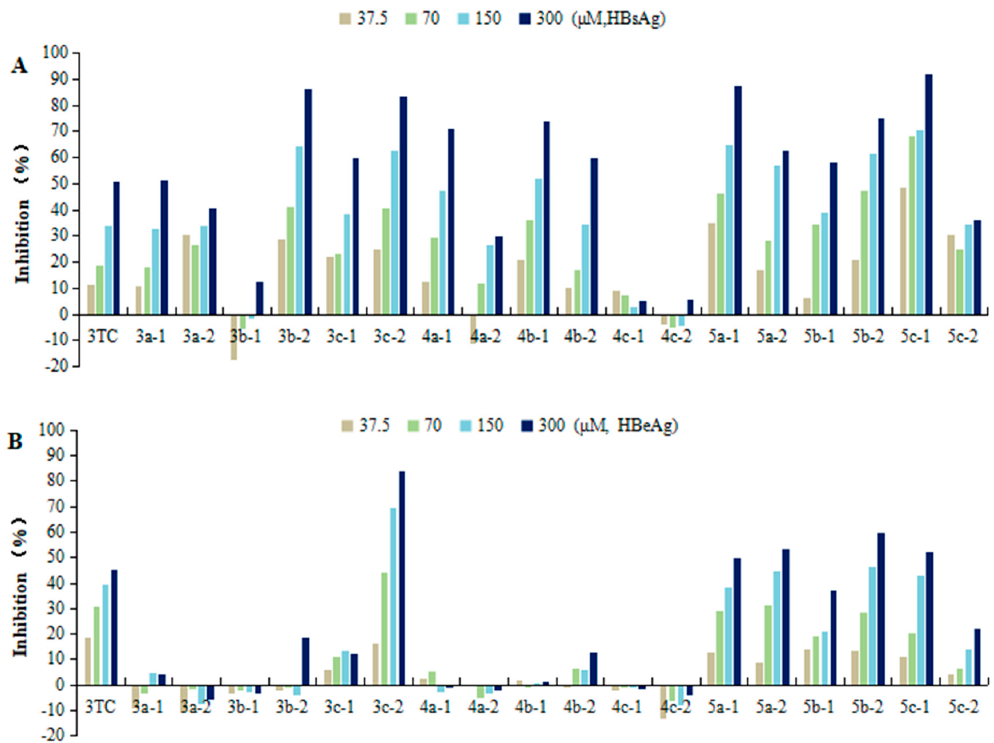
Figure 4. Inhibitory effects of the compounds on secretion of HBsAg ( A ) and HBeAg ( B ) in the HepG 2.2.15 cell line. Date were expressed as mean ± S.D. ( n = 3).